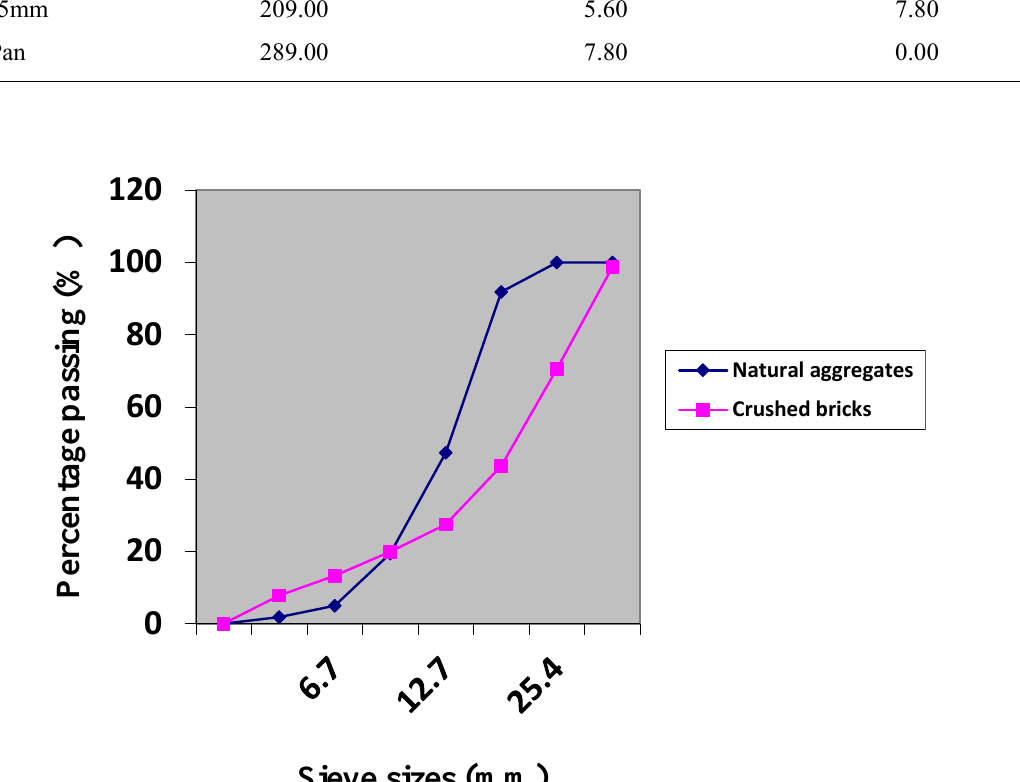
Fig. 2. Sieve analysis graph for coarse